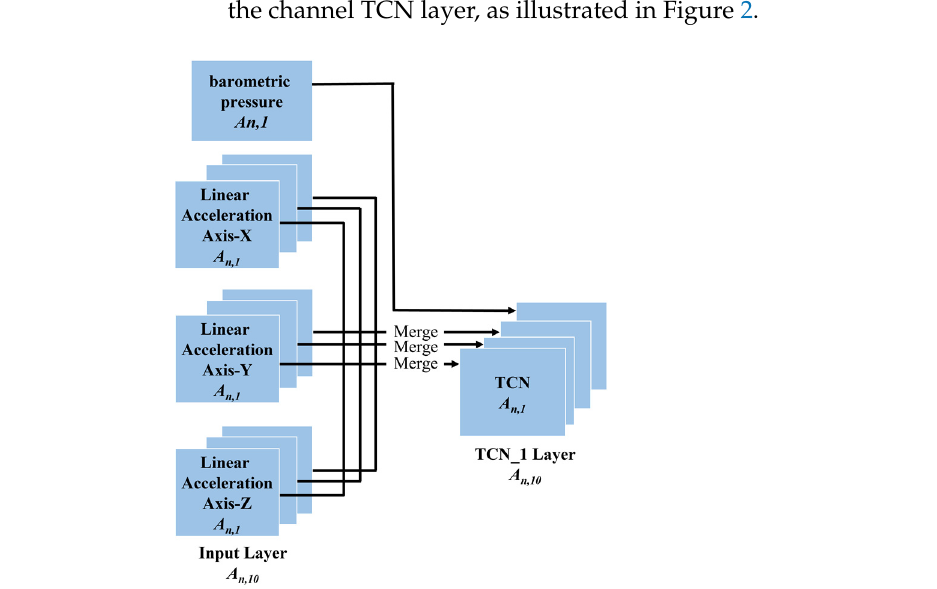
Figure 2. The overview of the proposed multimodal input layer. A_(n,d,10) is converted into ten tensors denoted by 𝐴 (cid:3041),(cid:3031),(cid:2869) , which are fed into ten channel TCN layers, respectively.